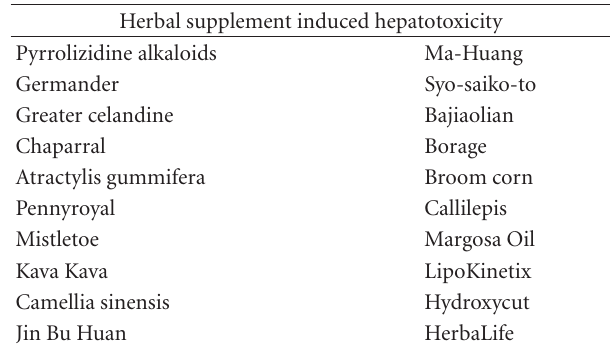
Table 3: Common herbal supplements associated with hepatotoxi- city. Herbal supplement induced hepatotoxicity Pyrrolizidine alkaloids Ma-Huang Germander Atractylis gummifera Broom corn